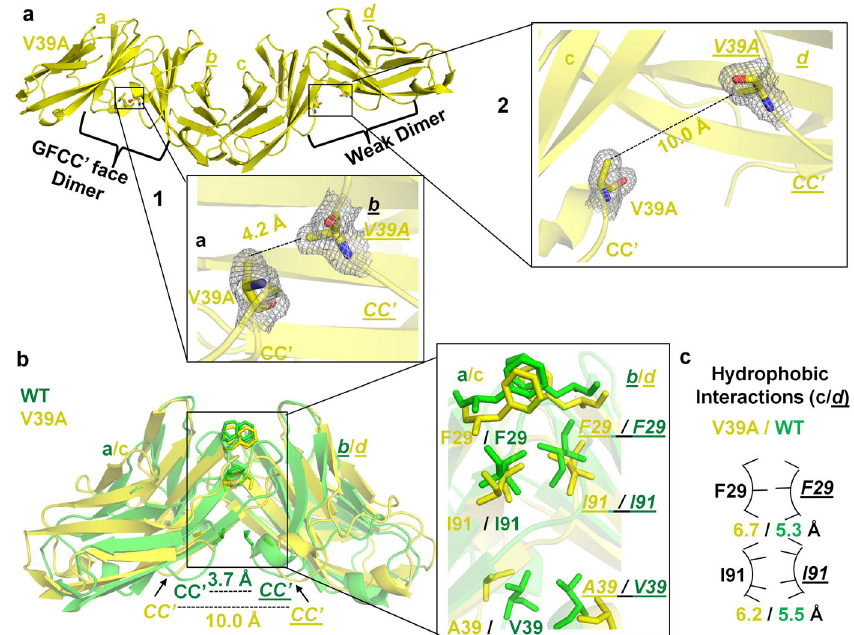
Fig. 4 Crystal structures of the V39A IgV mutant of hCEACAM1. a Ribbon diagram (yellow) of the molecules (a), ( b ), (c), and ( d ) as observed in the unit cell of the V39A crystal structure. The molecules (a) and ( b ) make a dimer that mimics a GFCC ′ face dimer as observed in the hCEACAM1 (PDB code 4QXW) crystal structure (1 inset ) . The molecules (c) and ( d ) make a weak GFCC ′ face dimer where the FG and speci fi cally the CC ′ loops are far apart and very few GFCC ′ face residues mediate the interactions (2 inset). The insets show V39A residues of these four molecules by stick representation with electron densities (2Fo – Fc map at 1.0 σ level) and the carbon atoms in yellow, carbonyl oxygen in red, and nitrogen in blue, are colored, respectively. In the 1 inset, the distance between β carbons of V39A residues of the molecules (a), and ( b ) is shown by dashed line (4.2 Å), whereas the 2 inset shows increased distance between CC ′ loops of weak dimer with distance of 10.0 Å between β carbons of V39A residues of the molecules (c) and ( d ). b The superimposition of the V39A mutant weak dimer (molecules c and d , colored yellow) and WT (molecules a and b colored green), whereas CC ′ loops are further apart in the V39A mutant weak dimer (yellow) compared to WT (green) as measured by distance between β carbons of V39A residues of 10.0 Å in the V39A mutant weak dimer vs 3.7 Å for WT. The inset shows stick representation of the residues F29, A39 and I91 of the weak V39A dimer (yellow), which make weaker hydrophobic interactions compared to WT F29, V39, and I91 residues (green). The A39 and V39 residues of the weak V39A dimer and WT dimer are shown by yellow stick and green stick/solid arrows, representation, respectively. The residues of molecule ( b ) of WT (green) and molecule ( d ) of weak V39A dimer (yellow) are shown in italics and underlined, respectively. c The arc/stick representation of weaker hydrophobic interactions by F29, and I91 residues as observed between molecules (c) and ( d ) in the formation of weak V39A dimer of the V39A crystal structure relative to WT. The residues of molecule ( d ) are shown in italics and underlined, respectively. The distances of hydrophobic interactions as measured by distance between β carbons of labeled residues are shown in yellow and green for the V39A weak dimer and WT, respectively, and weaker hydrophobic interactions for V39A weak dimer are depicted by fewer pointers on the hydrophobic arc relative to